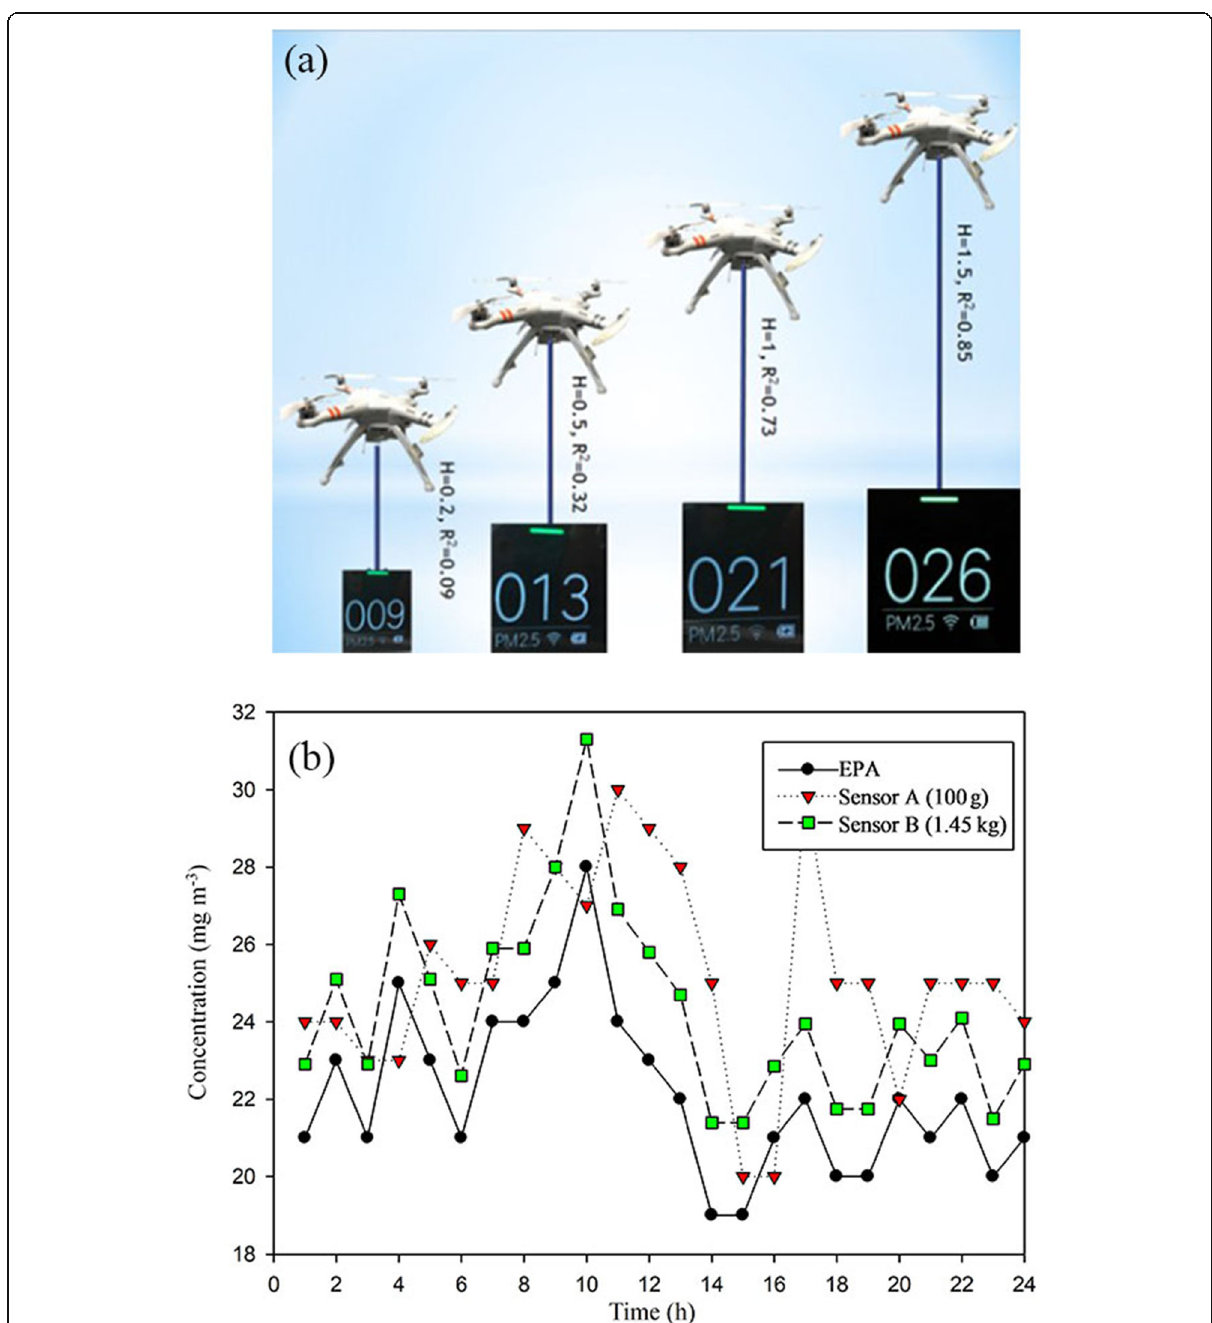
Fig. 9 a Hanging length with a sensor; b comparison of data from the UAV and EPA